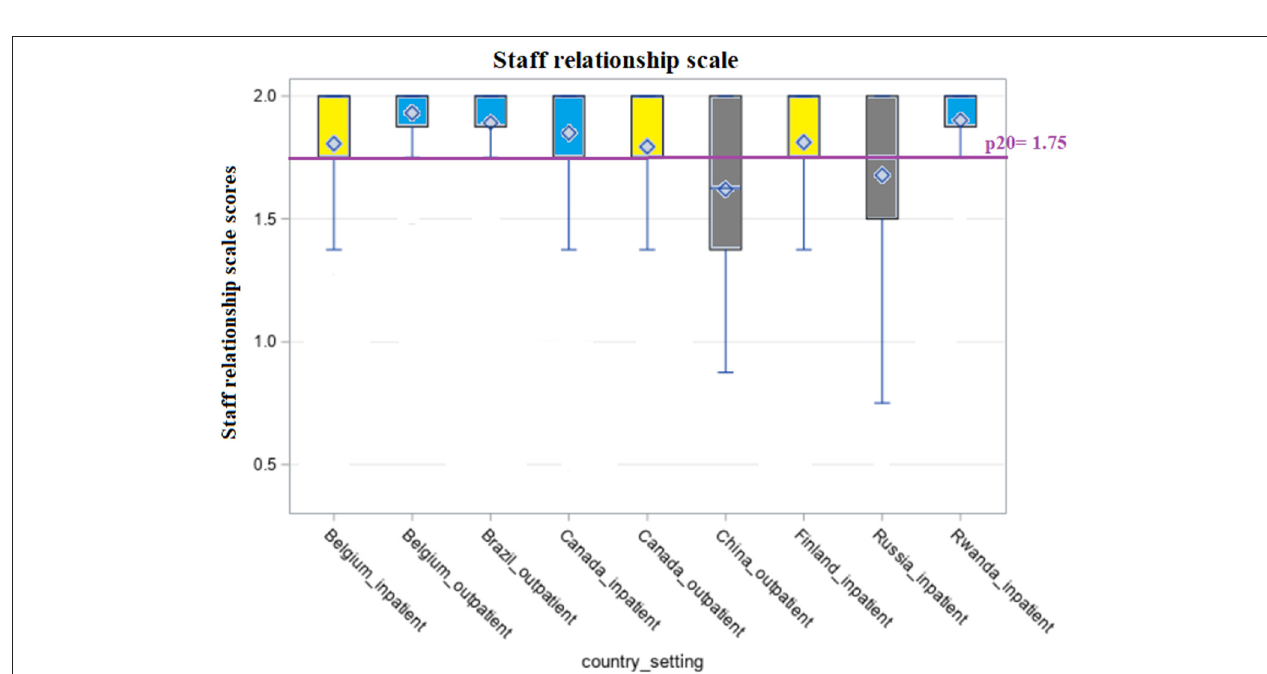
FIGURE 5 | Distribution of scores of the scale “Relationship with staff” across countries and